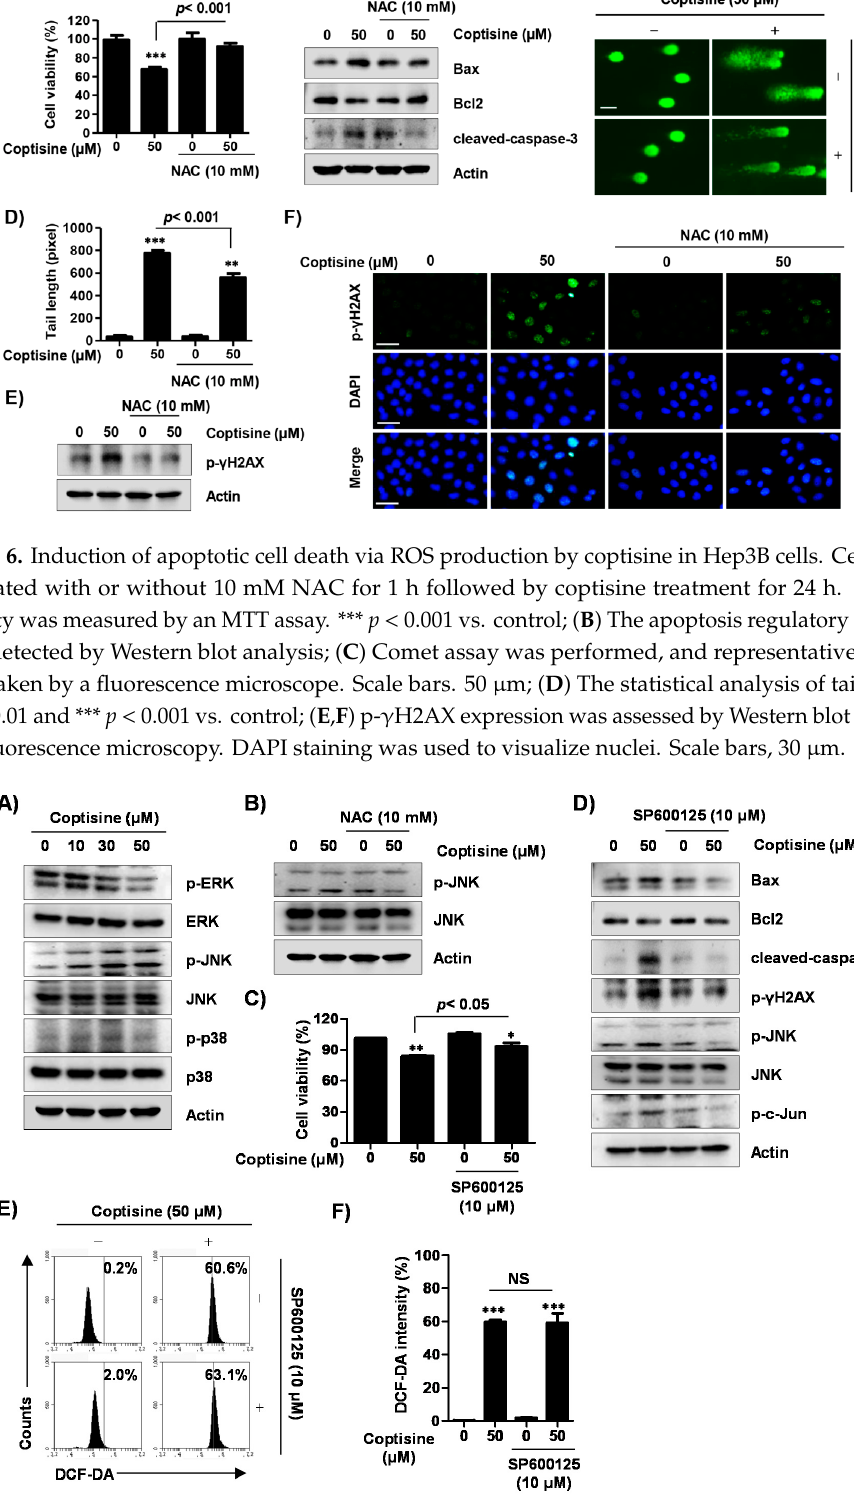
Figure 7. Role of c-Jun N-terminal kinase (JNK) signaling pathway in coptisine-induced apoptotic cell death in Hep3B cells. ( A ) Cells were treated with the indicated concentration of coptisine for 24 h, and then harvested. The isolated proteins were probed with primary specific mitogen-activated protein kinase (MAPK) antibodies; ( B ) Cells were pretreated with or without 10 mM NAC, for 1 h, followed by coptisine treatment for 24 h. Lysate proteins were subjected to anti-p-JNK and anti-JNK antibodies; ( C , D ) Cells were pretreated with or without 10 µM SP600125, for 1 h, before coptisine treatment for 24 h. In (C), cell viability was determined by MTT assay. The results are presented as the mean ± SD of three independent experiments. * p < 0.05 and ** p < 0.01 vs. control. In (D), expression of apoptosis- related proteins was analyzed by Western blot analysis; ( E , F ) The cells were pretreated with or without 10 µM SP600125 for 1 h before coptisine treatment for 30 min. Cells were harvested and stained with DCF-DA, and the ROS levels detected by flow cytometry. In ( E ), representative results. In ( F ), each bar indicates the fluorescent intensity for DCF-DA. The results are presented as the mean ± SD of three independent experiments. *** p < 0.001 vs. control. NS means not significant. 3. Discussion Coptisine is one of the active compounds discovered in Rhizoma coptidis [14]. Although its anticancer function has been reported for various types of cancers including HCC liver [18–20], the underlying mechanism for the anticancer activity of coptisine in HCC is unclear. Therefore, in the present study, we examined the anticancer effect of coptisine on HCC Hep3B cells and sought to identify the action mechanism. Apoptosis is a very tightly programmed cell death process that plays a crucial role in several biological processes in normal tissues. Defects in apoptosis can promote tumor development, and also make cancer cells resistant to treatment. In this respect, the evasion of apoptosis is a noticeable hallmark of cancer [25,26]. Actually, cancer cells show impaired apoptotic signaling, which results in facilitating the development and metastasis of tumor [27,28]. In addition, the main goal of clinical oncology has been the development of therapies promoting the effective elimination of cancer cells by apoptosis for over several decades [29]. Therefore, the present study focused on the anticancer